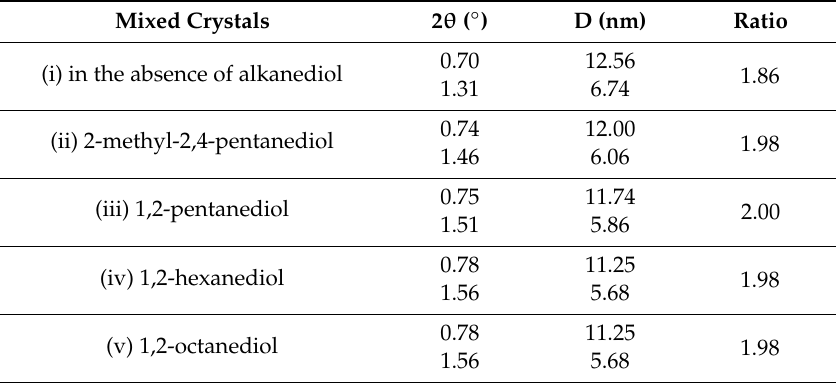
Table 4. Lamellar distances of mixed crystals of cetostearyl alcohol, polysorbate 60, water and in the presence of di ff erent